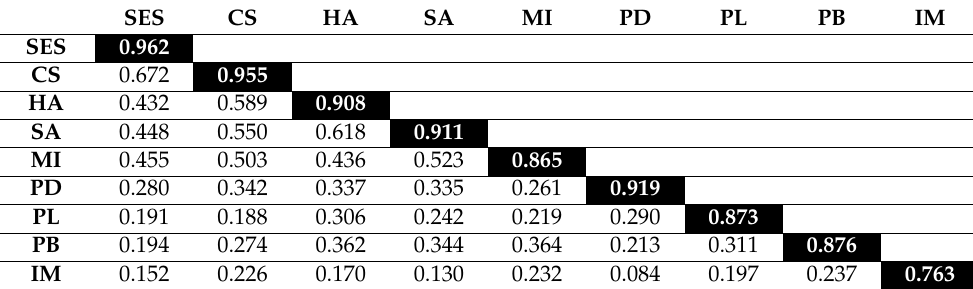
Table 5. Discriminant